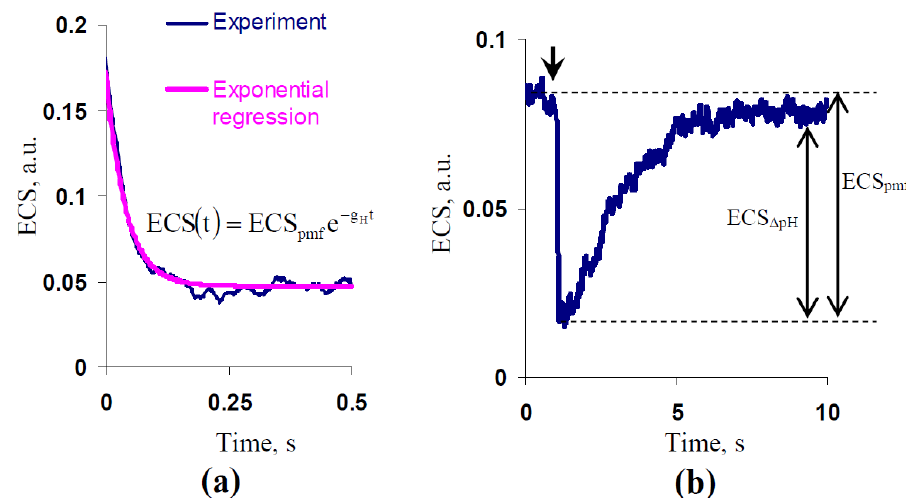
Figure 11. ( a ) Schema of measurement of g H , which was calculated as the exponential velocity of the dark relaxation of ECS. The zero point shows the termination of illumination by AL; ( b ) schema of measurements of ECS pmf , ECS ΔpH, and ECS Δψ . The arrow shows the termination of illumination by AL.